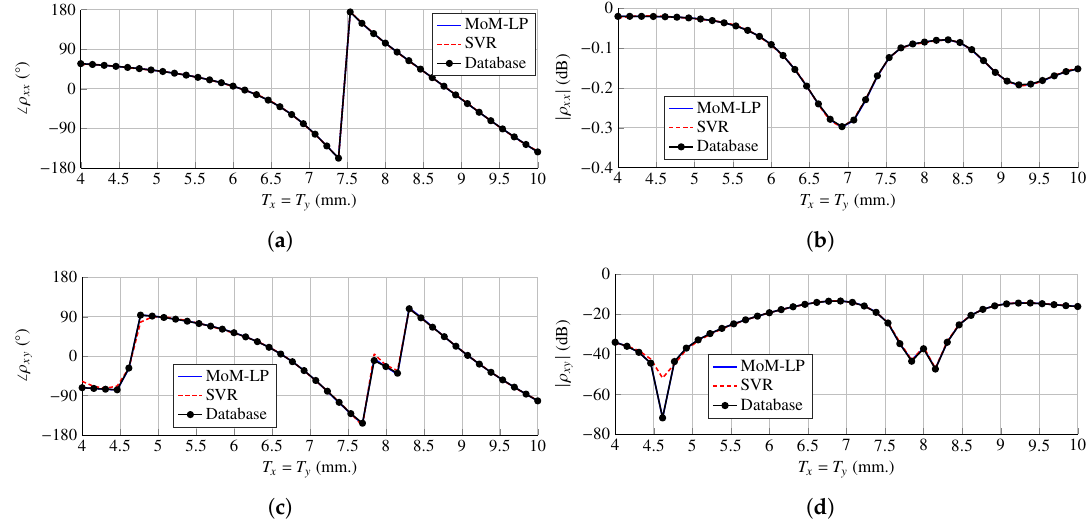
Figure 4. Comparison of a ( a , b ) direct ( ρ xx ) and ( c , d ) cross-coefficient ( ρ xy ) values in ( a , c ) phase and ( b , d ) magnitude between the MoM-LP, SVR and database tools for an oblique incidence at ( θ , ϕ ) = ( 29 ◦ ,35 ◦ ) . When not visible, the curves are superimposed on each